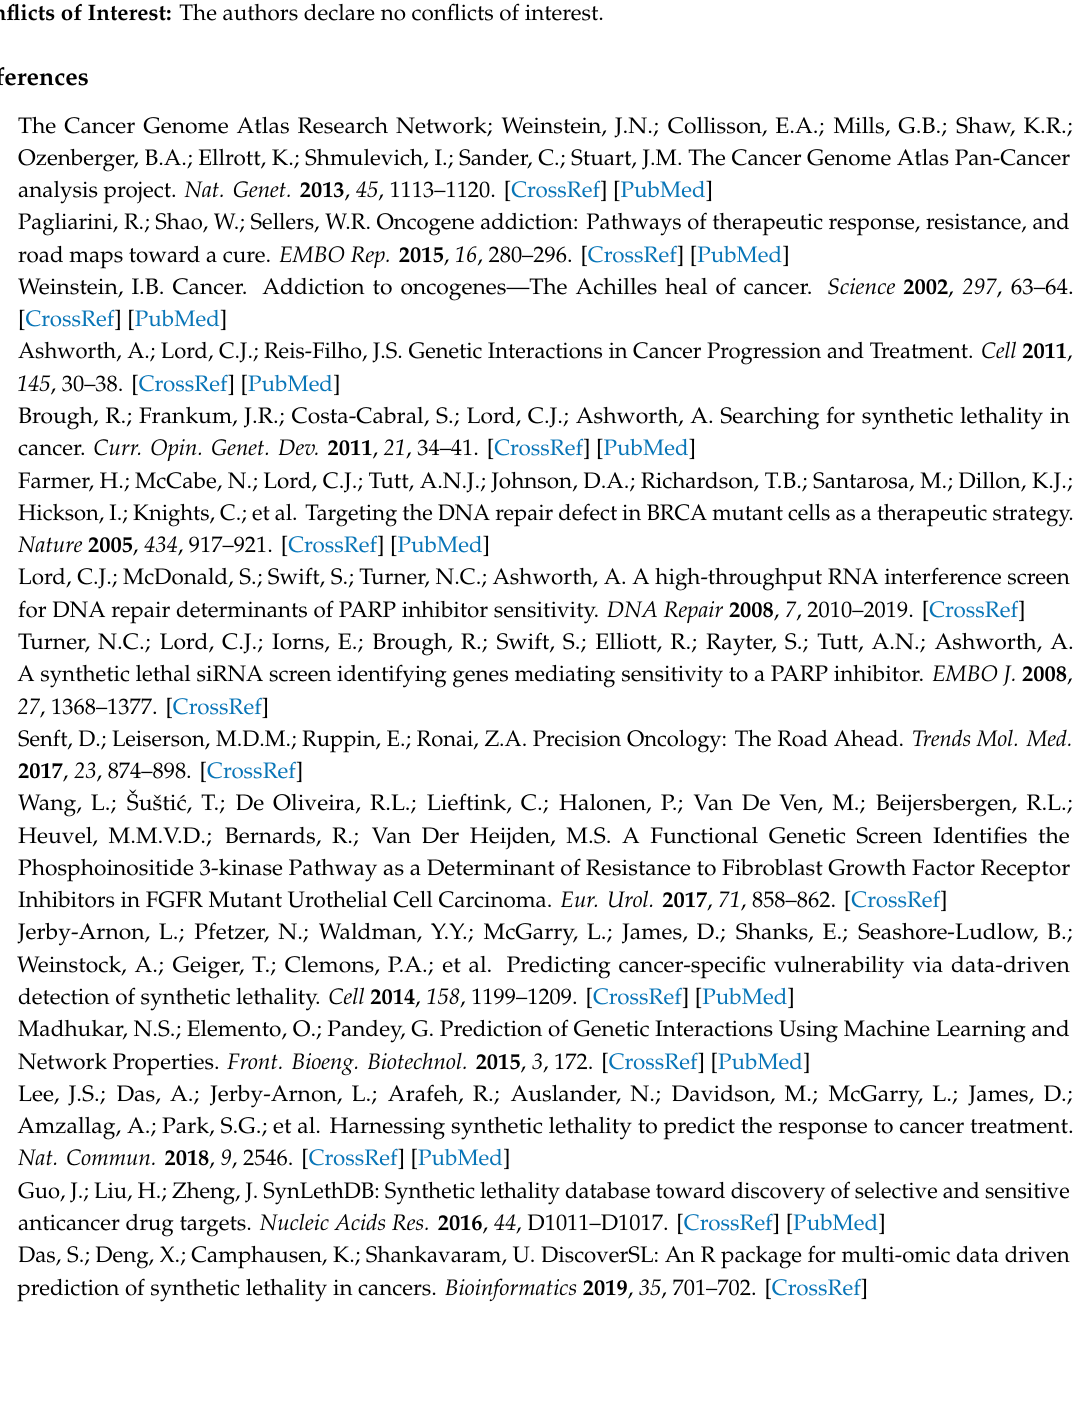
S2: Primary genes and SL drugs for multiple cancer types, shown in Figure 2a, Table S3: Primary genes and pathways shown in Figure 2a, Table S4: Inferred drug synergy from SL interactions, Table S5: SL drug sensitivity depending on mutations in primary genes, Table S6: Drug sensitivity and pathway enrichment for primary